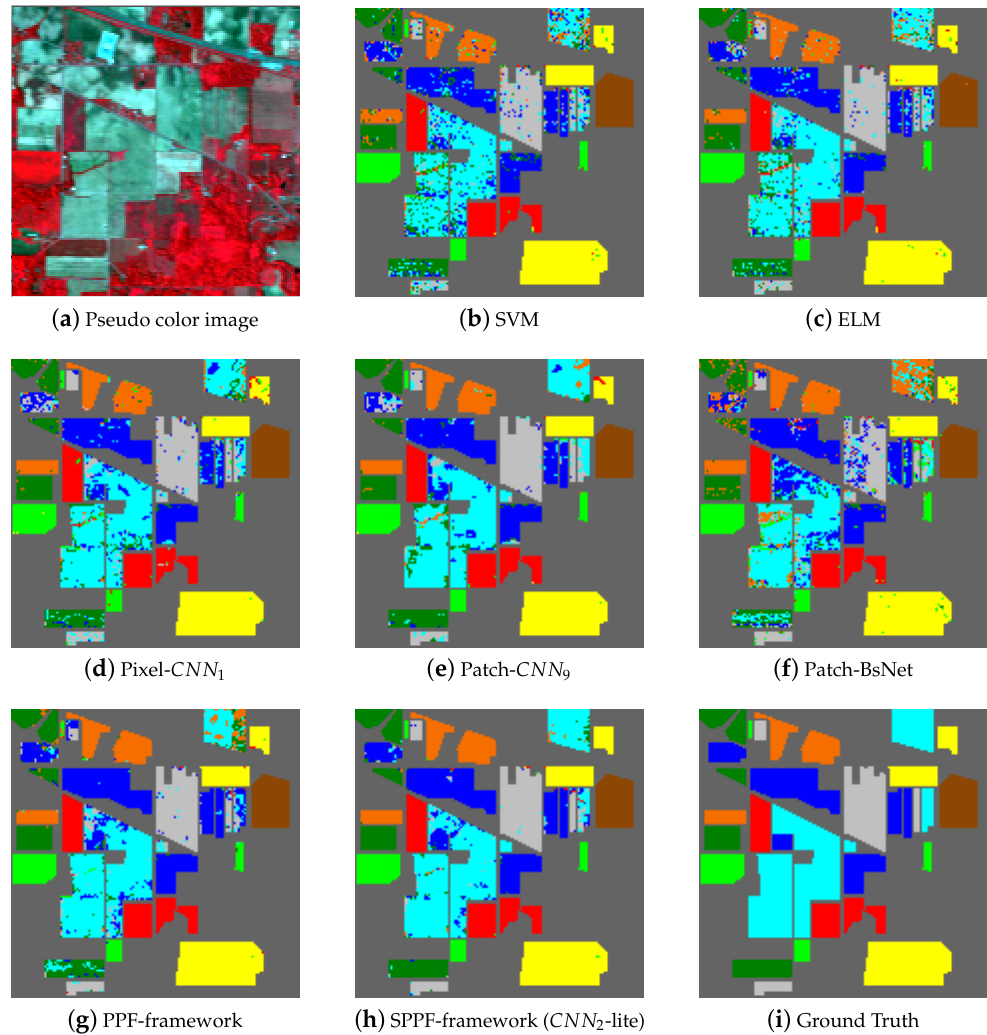
Figure 5. Results on the University of Pines dataset. ( a ) Pseudo color image of the scene. ( b – h ) Results from competing methods. ( i ) The ground truth. Our algorithm achieves the best classification accuracy among the competing methods. (Best viewed in